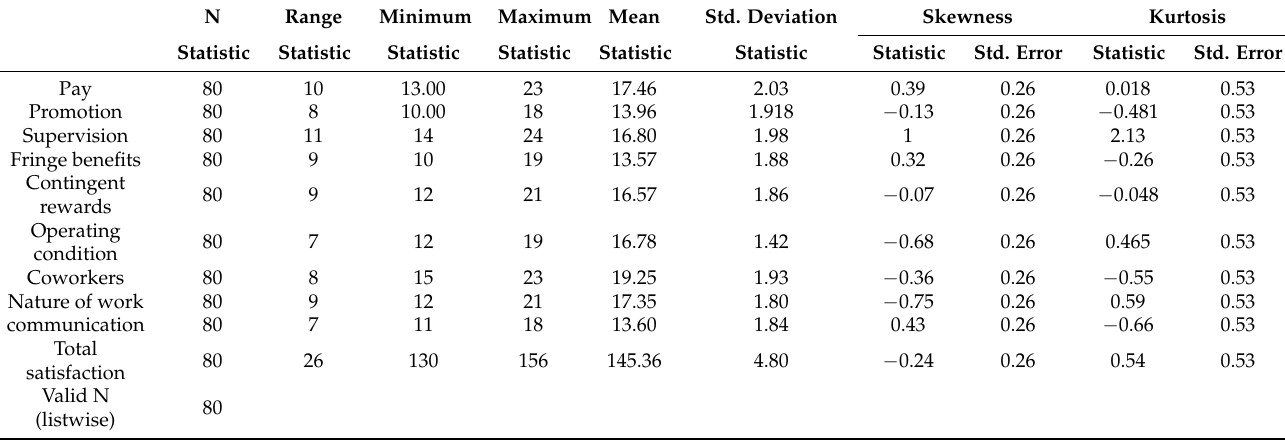
Table 5. Descriptive statistics of scales of